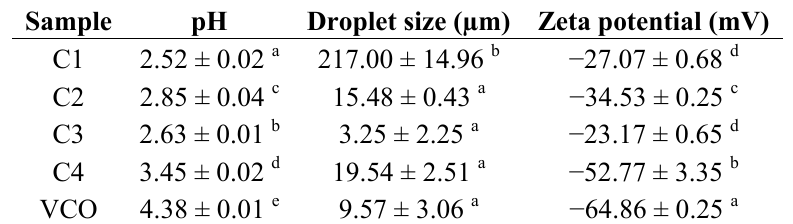
Table 2. pH, droplet size and zeta potential of the commercial emulsion samples and virgin coconut oil emulsion.